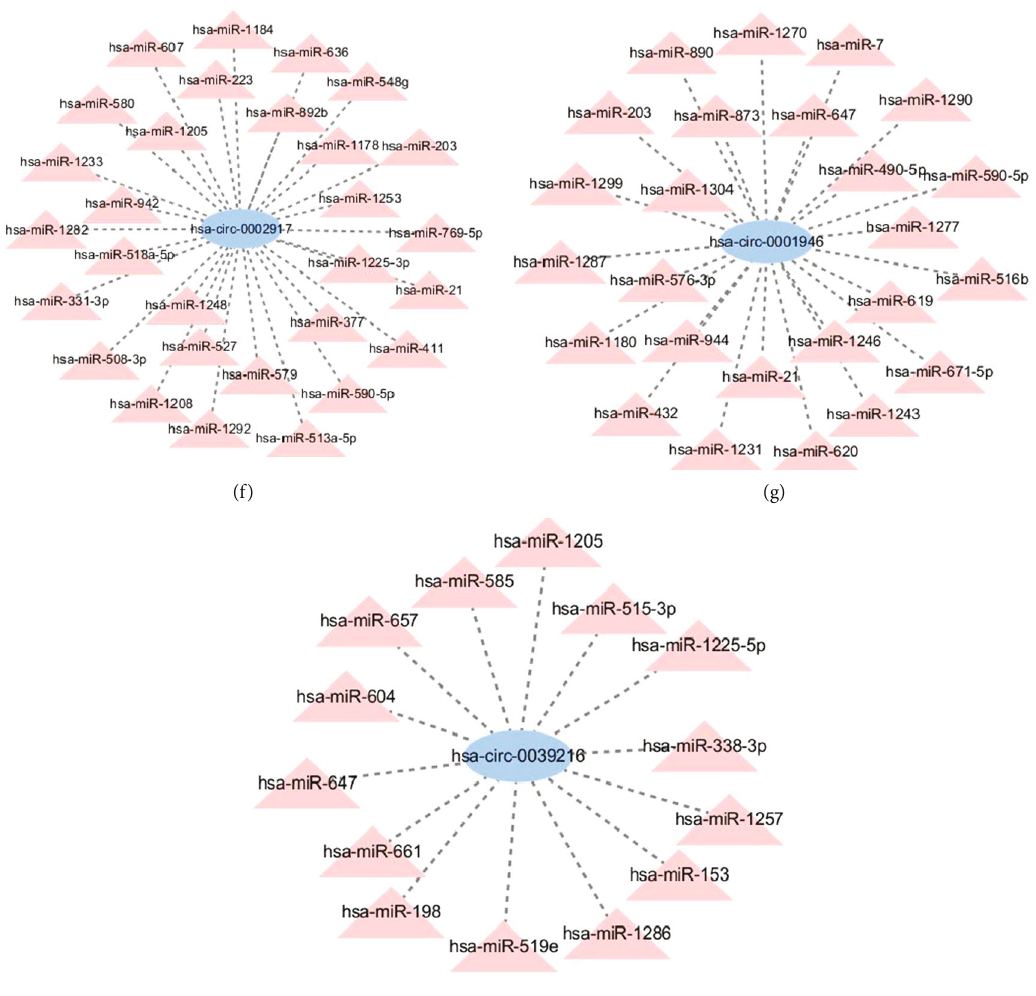
Figure 5: (a) The structure of DEcircRNAs. The red, blue, and green regions inside the circular RNA molecule, respectively, represent MRE (microRNA response element), RBP (RNA-binding protein), and ORF (open reading frame). (b – h) The circRNA-miRNA network diagrams. Pink represents upregulated DEcircRNAs, and blue represents downregulated